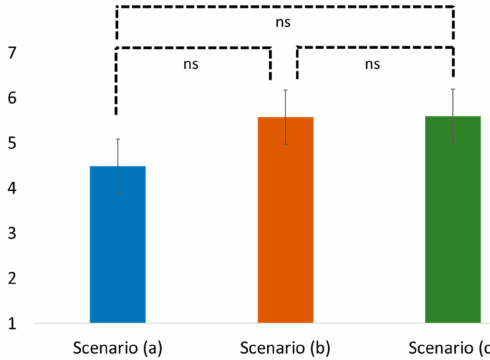
Figure 3. Comparison of worship intention in di ff erent scenarios. Note: ns stands for